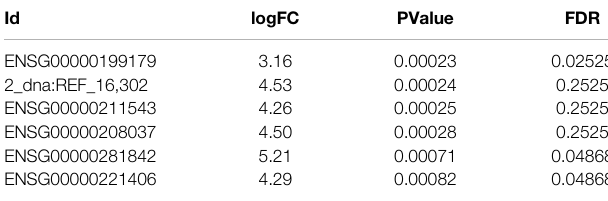
TABLE 2 | miRNAs with ID starting with “ ENSG ” are known